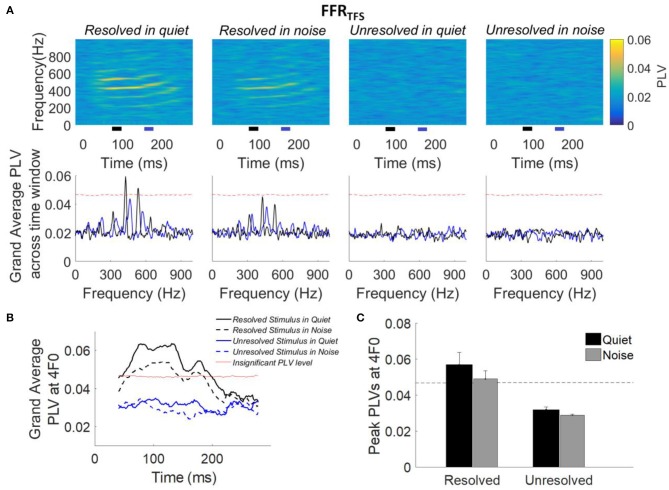
(A) Grand average PLVs of FFRTFS (top panel) as a function of time and frequency for each condition. The horizontal axis represents the midpoint of the 80 ms time window used for spectral phase calculation, the vertical axis represents the frequency, and the color represents the magnitude of PLV at each time and frequency. The grand average FFRTFS PLV across participants (bottom panel) as a function of response frequency at two different time slides. The black and blue line represents the averaged PLV from 80 to 100 ms (black bar) and from 160 to 170 ms (blue bar). The black and blue bar showed in the bottom of the top panel. (B) Grand average PLV curves at 4F0 for each stimulus condition. Responses above the red line are significantly greater than the noise level (p < 0.01). The time represents the midpoint of the 80 ms analysis window. (C) Peak PLVs at 4F0 averaged across participants for each stimulus condition. Error bars represent one standard error. Responses above the dashed back line are significant (p < 0.01).